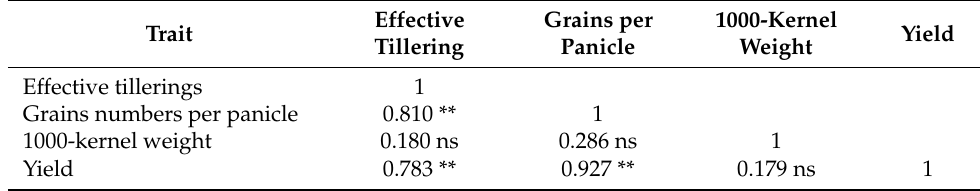
Table 2. Correlation analysis between rice yield and yield